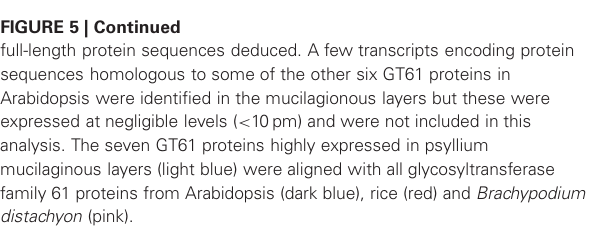
FIGURE 5 | Continued full-length protein sequences deduced. A few transcripts encoding protein sequences homologous to some of the other six GT61 proteins in Arabidopsis were identified in the mucilagionous layers but these were expressed at negligible levels ( < 10pm) and were not included in this analysis. The seven GT61 proteins highly expressed in psyllium mucilaginous layers (light blue) were aligned with all glycosyltransferase family 61 proteins from Arabidopsis (dark blue), rice (red) and Brachypodium distachyon